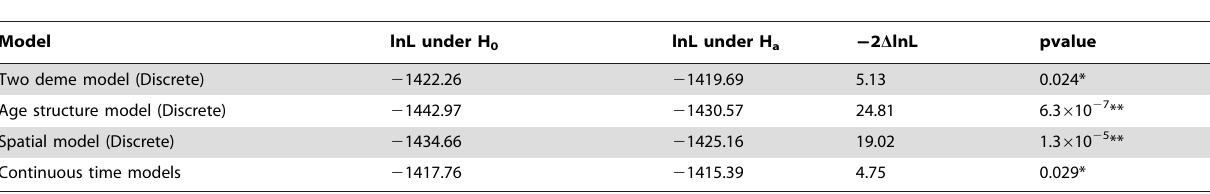
Table 2. Likelihood ratio tests under different